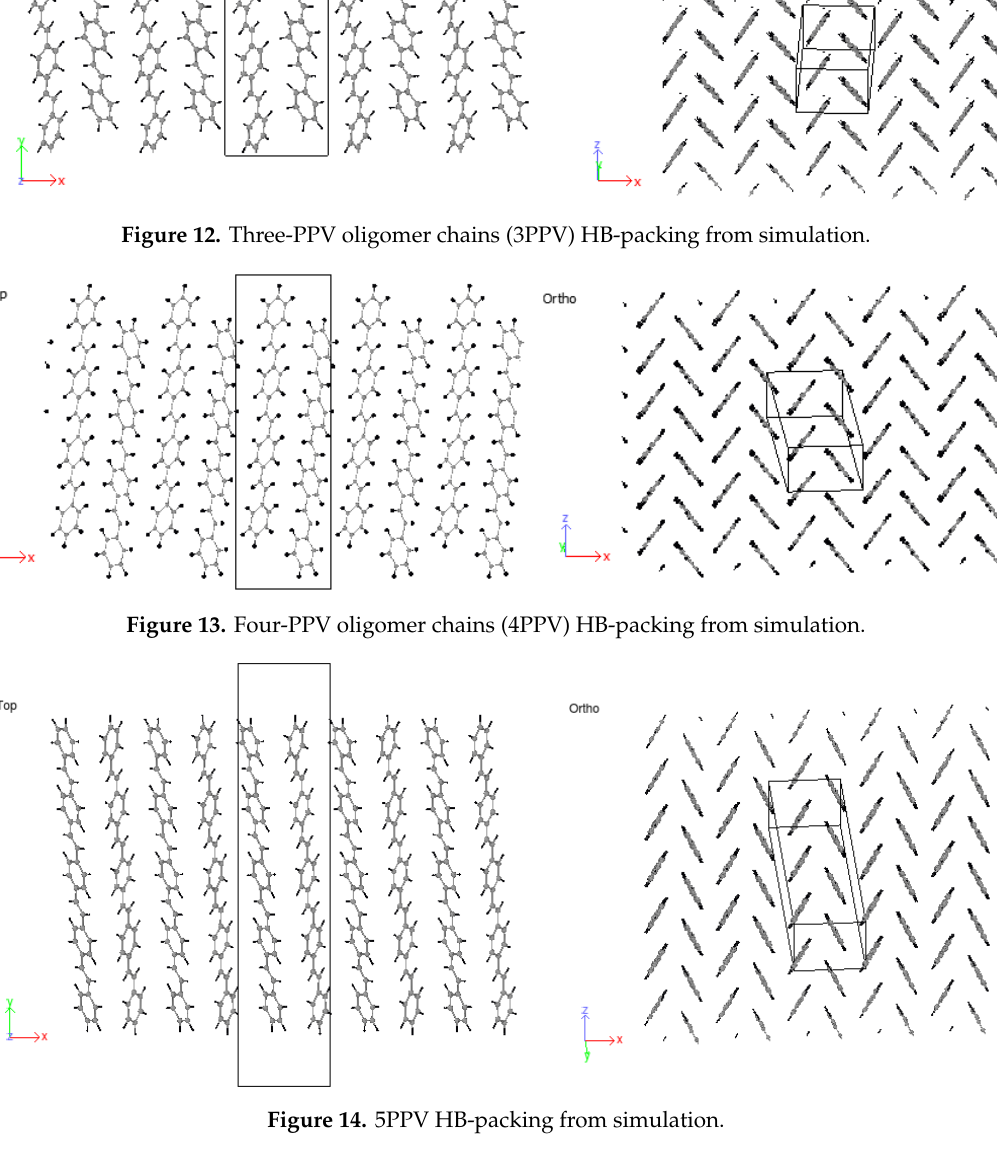
Figure 15. Intramolecular potential energy of PPV oligomers.